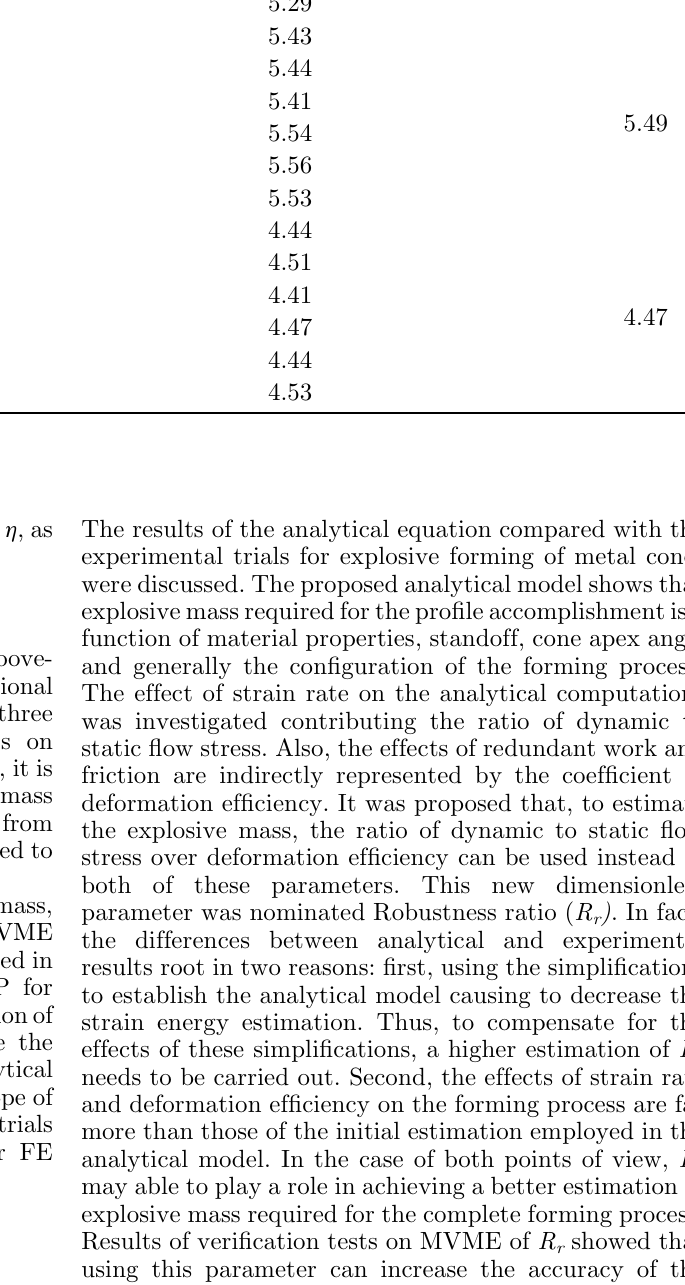
Table 5. Initial estimation, modi fi ed estimation and MVME for R